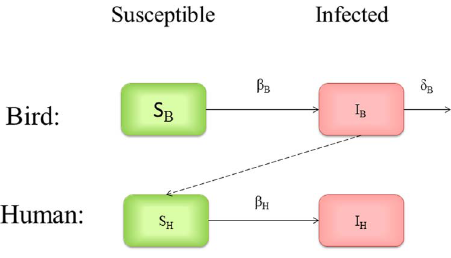
Figure 1. Model diagram for bird-human disease transmission